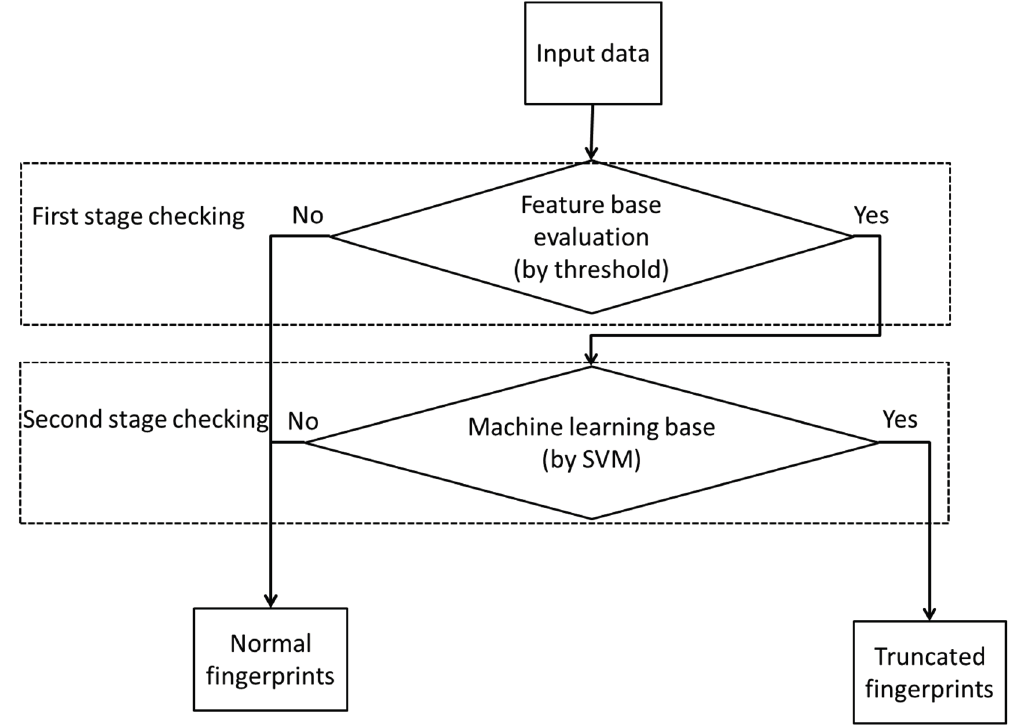
Figure 1. Flowchart of the proposed system for identifying truncated